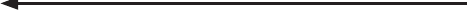
Figure 5: Three classes of bona fide SUMO E3 ligases. The SP-RING family is conserved from yeast to human and consists of Siz1, Siz2 and Nse2 in yeast and Pias1-4 and MMS21 in vertebrates. The common motif required for E3 activity is the SP-RING and its flanking regions that form the CTD domain (pastel red) and possess an N-termi- nal SIM-like motif. All Pias family members also share a SAP domain, a PINIT motif and a SIM. Nse2 and MMS21 only share the SP-RING and the C-terminal part of the CTD domain but are otherwise different. The RanBP2 E3 ligase activity was mapped to a vertebrate-specific region demonstrating two internal repeats separated by a middle region, IR1-M-IR2 (pastel blue). IR1 contains a classical SIM and the M region also binds SUMO but this interaction is not yet mapped. In addition, RanBP2 displays an N-terminal leucine-rich TRP repeat, four RanGTPase binding sites (R1-R4), eight tandem zinc fingers, multiple FG repeats (not indicated) and a cyclophilin-like (CY) domain. The ZNF451 family consists of four members, all sharing the N-terminal catalytic tandem SIM region (pastel green). ZNF451-1 to ZNF451-3 are differentially expressed from a single vertebrate specific gene locus. ZNF451-1 and ZNF451-2 differ only in one small exon. ZNF451-3, and the primate spe- cific KIAA1586, only share the tandem SIM region with its family members but are otherwise unrelated. ZNF451-3 displays a predicted Lap2 α domain and KIAA1586 has an ribonuclease H-like domain. Enlargements of the different catalytic domains are shown as